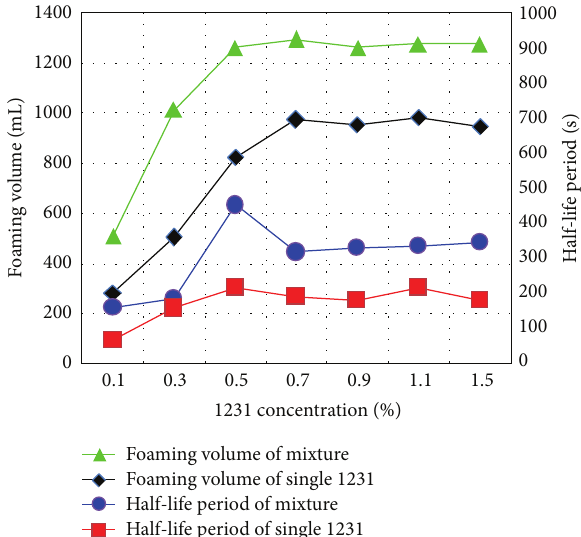
Figure 5: The foaming ability of single and mixture with 1231